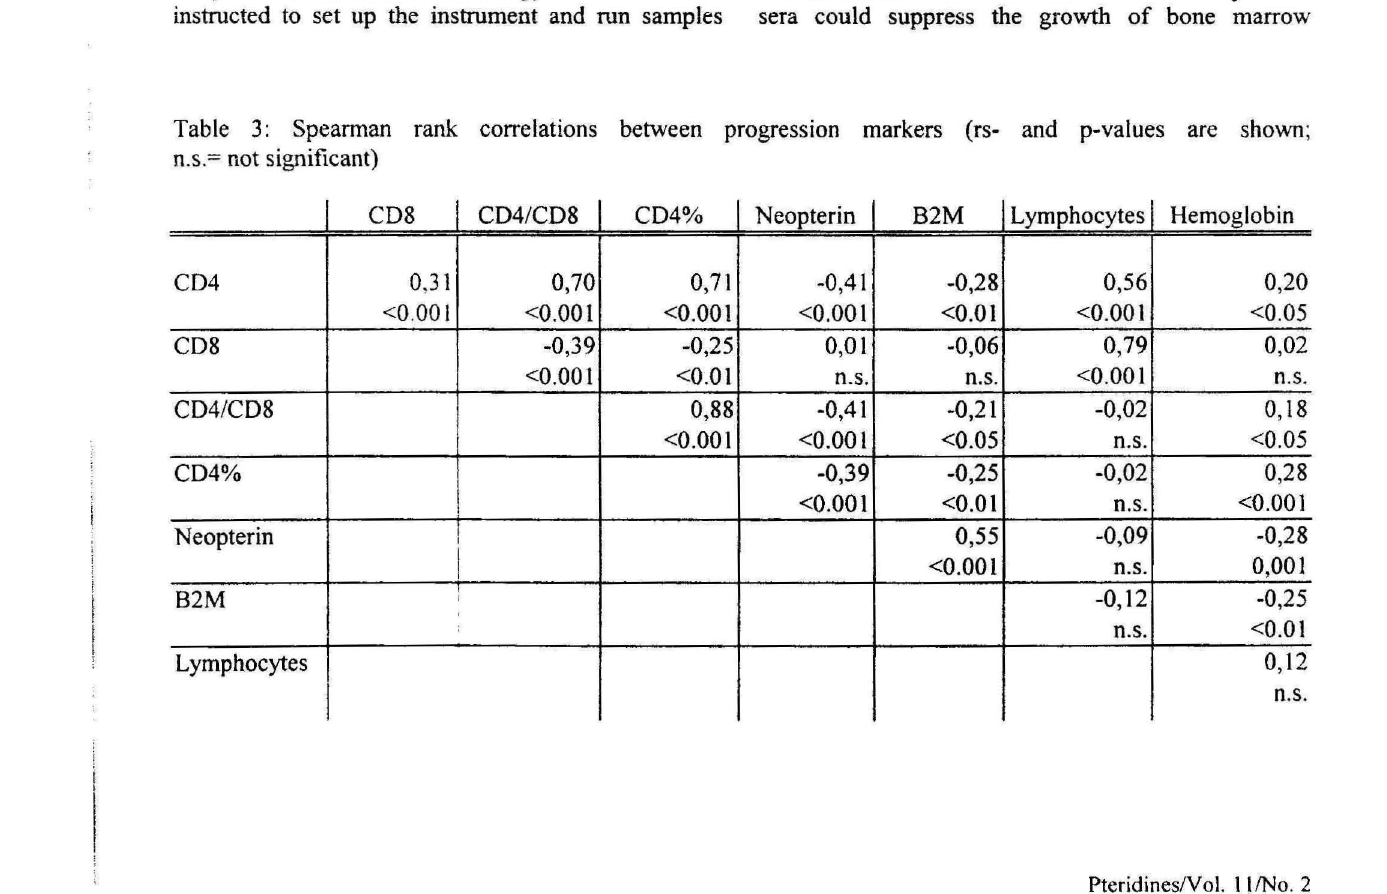
Table 3: Spearman rank correlations between progression markers (rs- and p-values are shown; n.s.= not